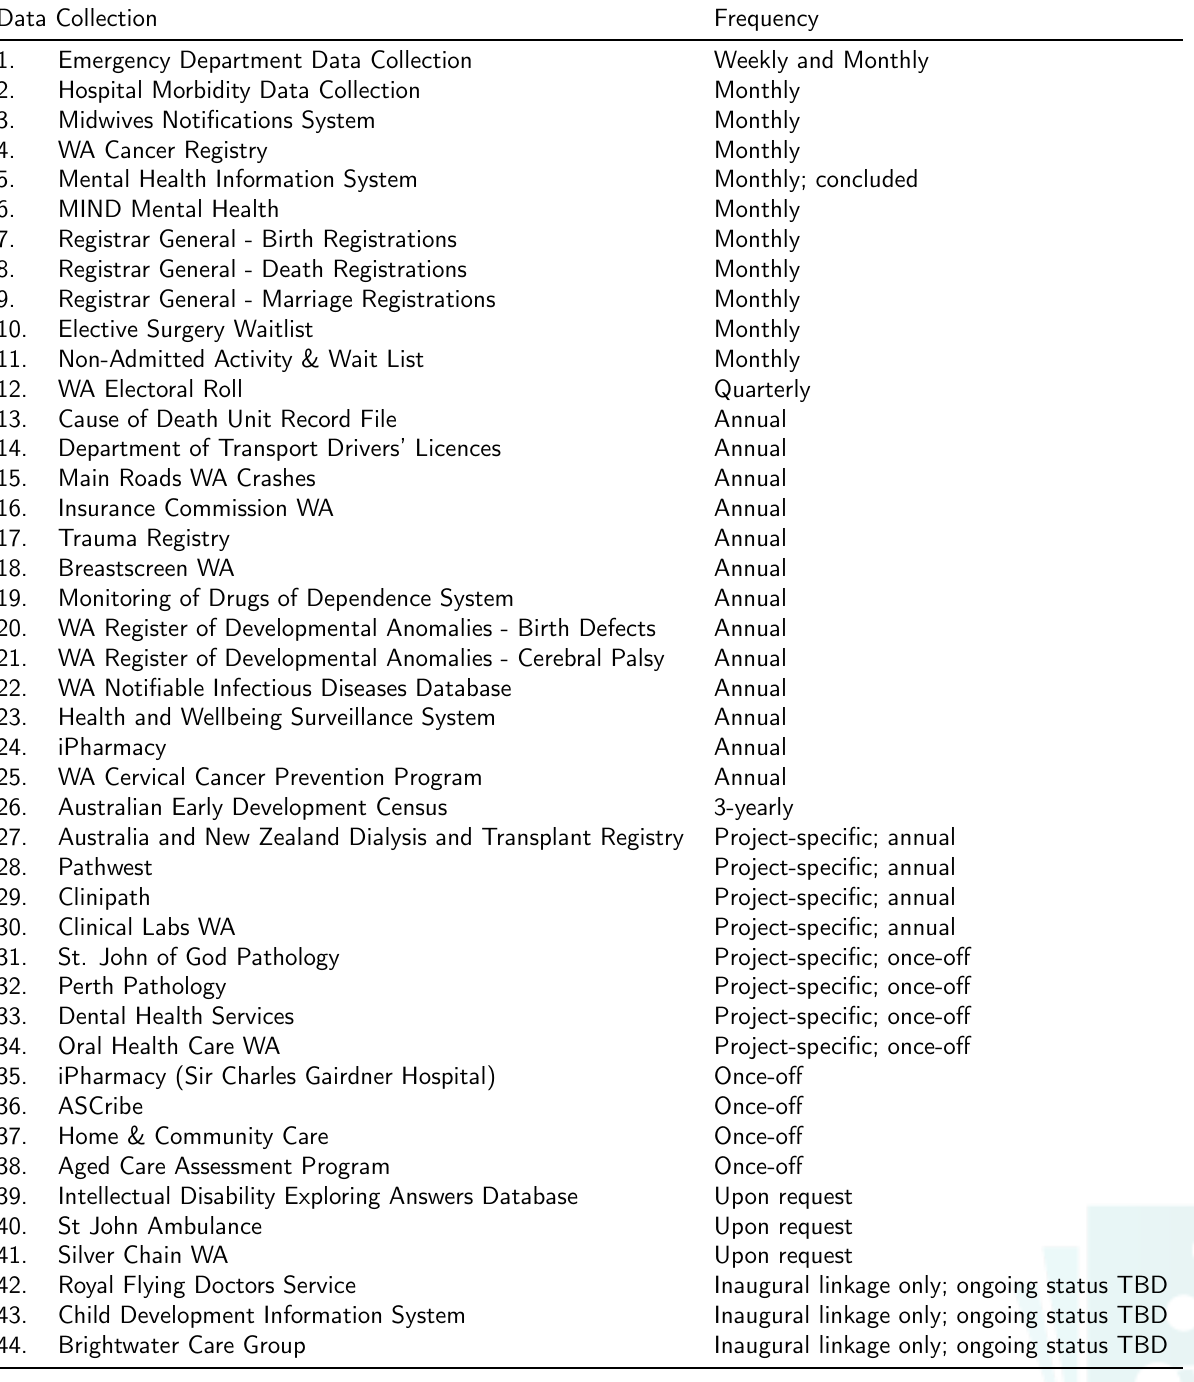
Table 4: Summary of Data Linkage Branch linkage infrastructure 2017 to